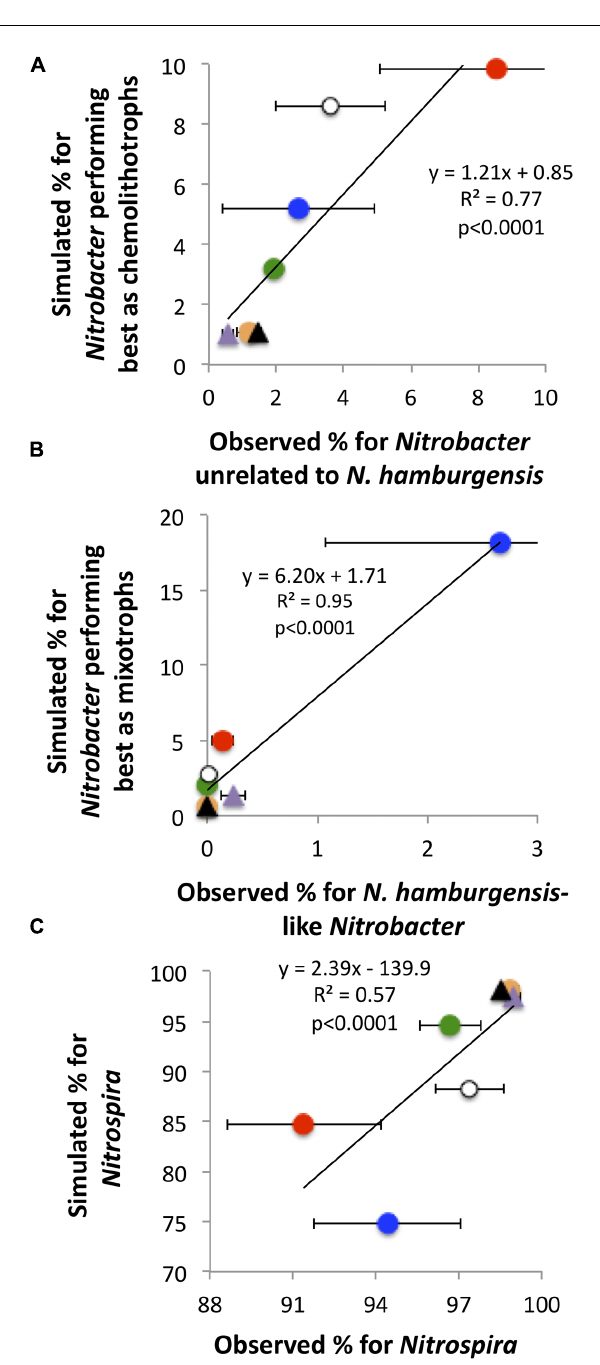
FIGURE 4 | Observed and predicted relative contributions of the three bacterial functional types to the total soil nitrite-oxidizing community (A: chemolithotrophic Nitrobacter ; B: mixotrophic Nitrobacter ; C: Nitrospira ). Observations ( X -axis) are mean values with standard errors for each global change treatment. Orange circle, CTRL; purple triangle, W; black triangle, NW; green circle, CO 2 ; red circle, CO 2 N; white circle, CO 2 W; blue circle, CO 2 NW. Modeling was not possible for the N treatment due to lack of measurements of N availability in soil. For (B) , simulation is for all mixotrophic Nitrobacter , whereas observation is for Nitrobacter affiliated to the strain N. hamburgensis disregarding the possible presence of other mixotrophic populations not affiliated to cultivated